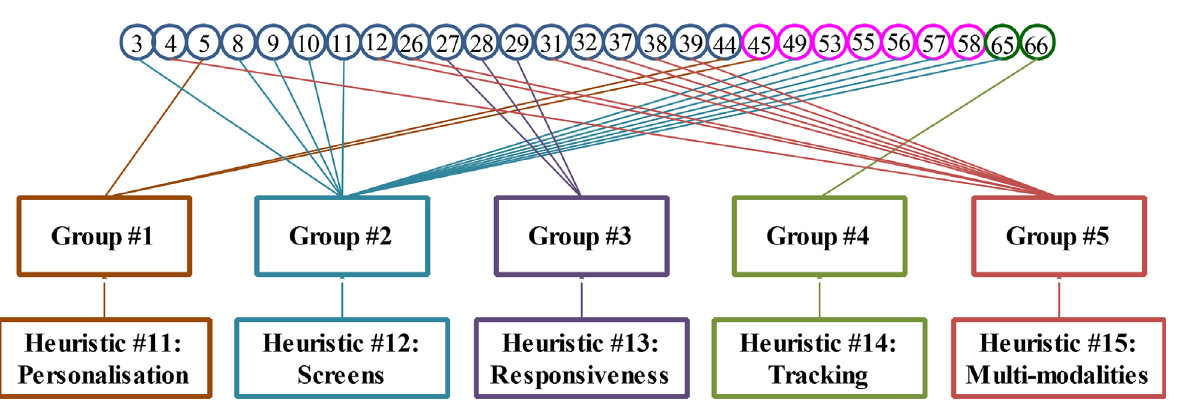
Fig 3. Grouping of remaining guidelines and creation of